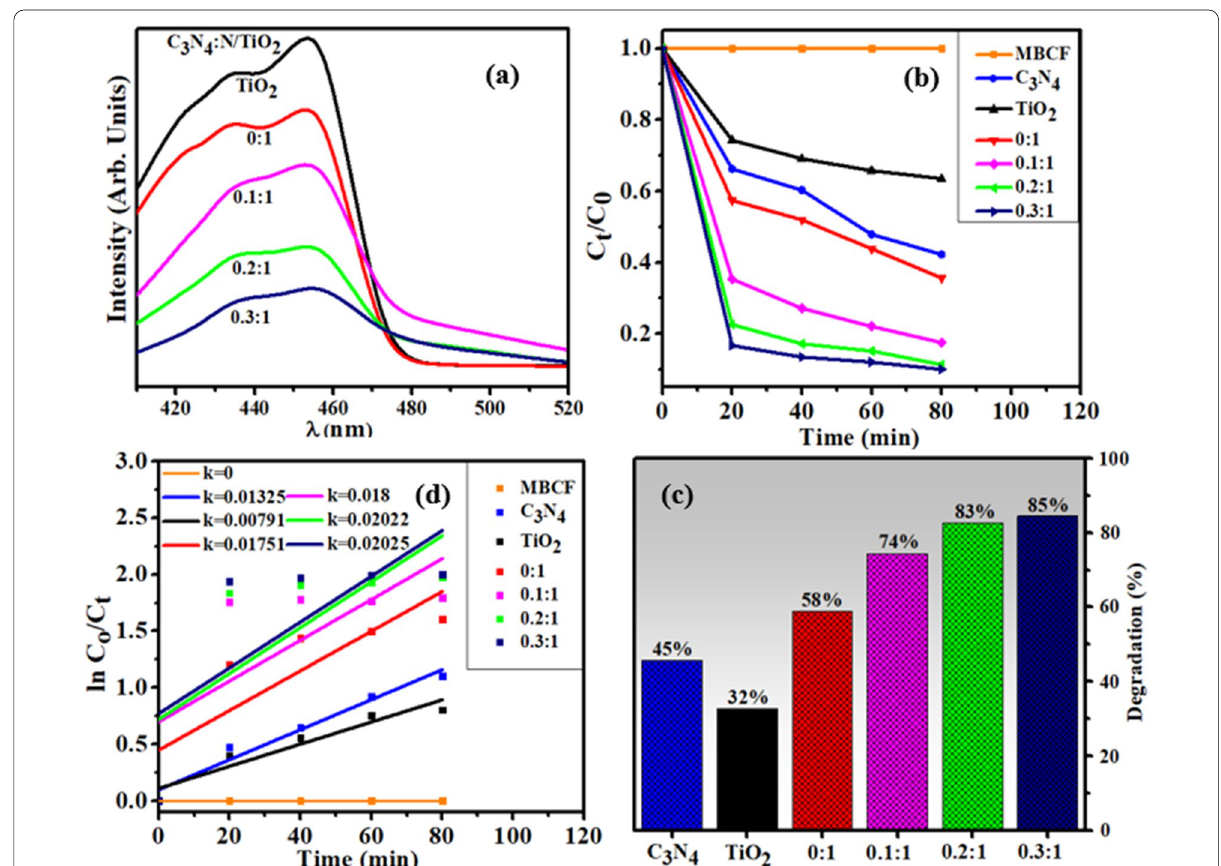
Fig. 6 a PL spectra ( b ) Plot of concentration ratio (C t /C o ) versus time ( c ) percentage (%) degradation of all samples ( d ) plot of ln(C o /C t ) versus time spectra for dye